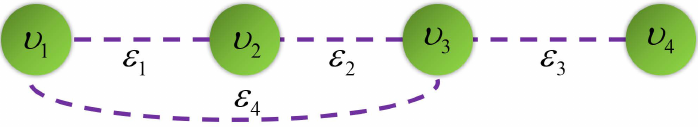
Figure 1. Communication